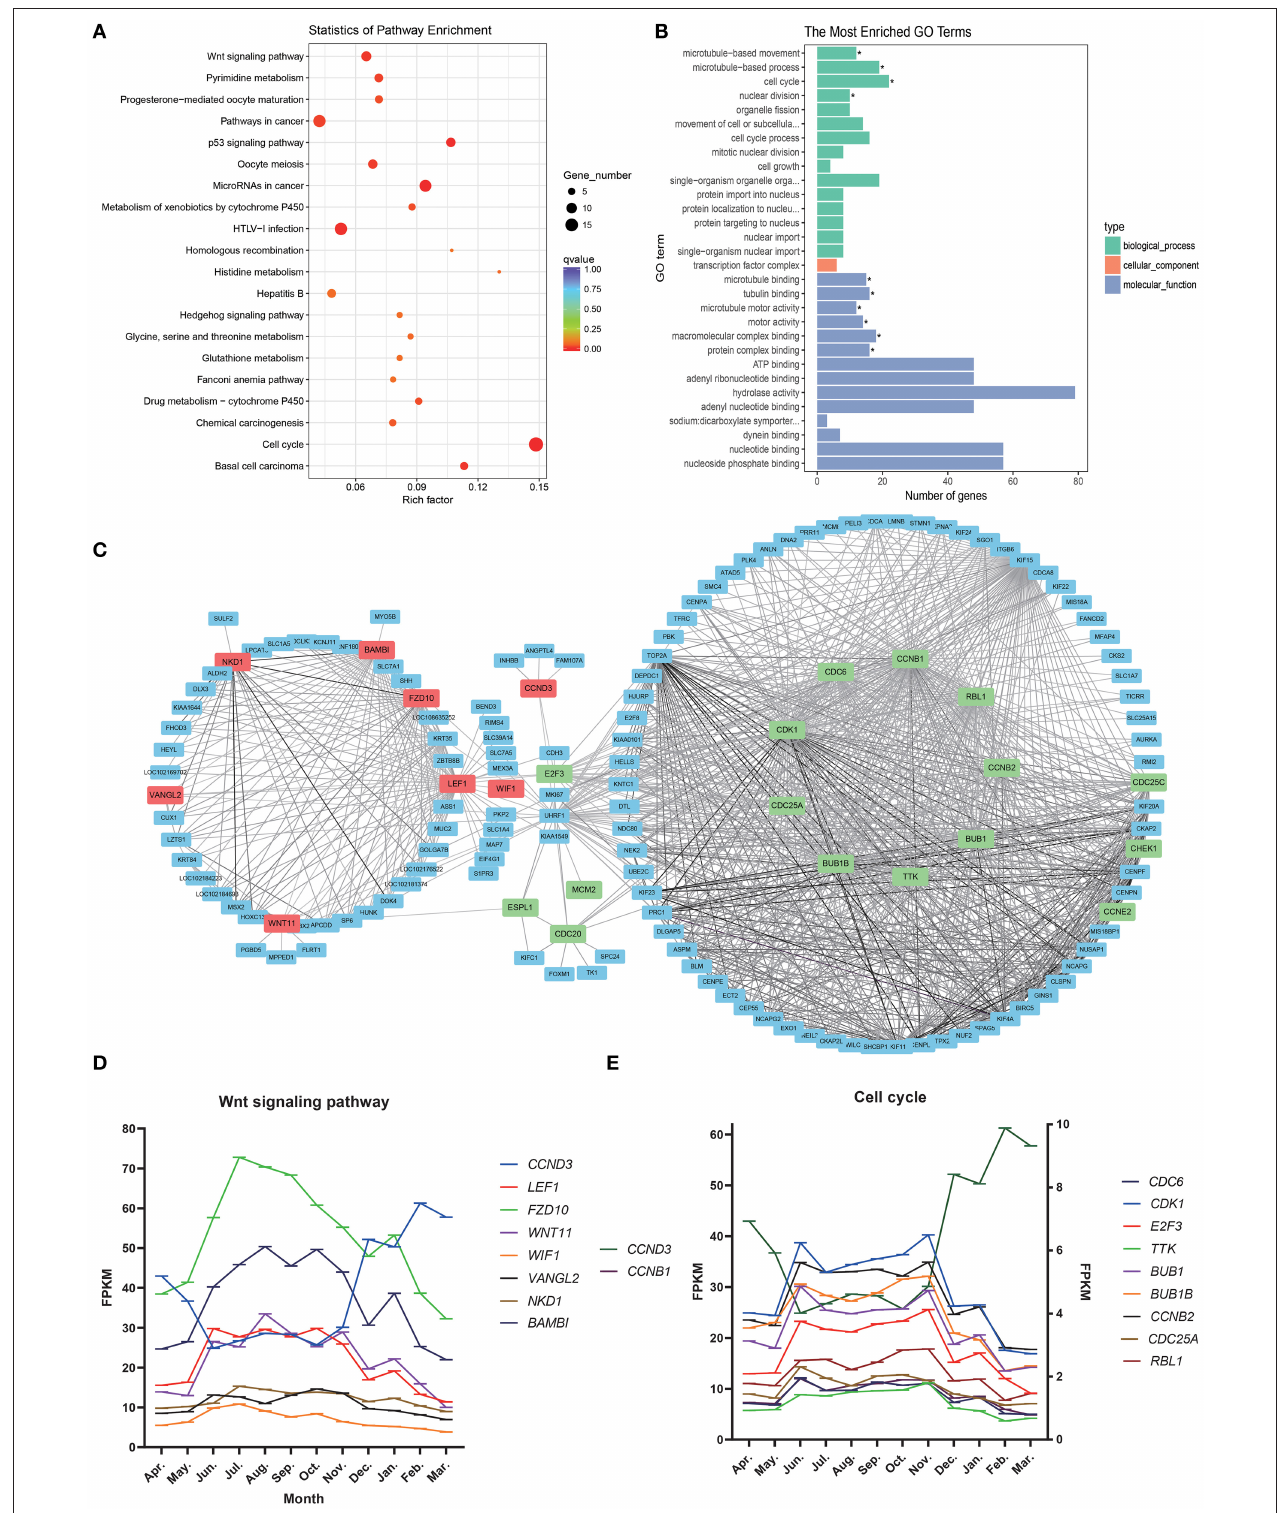
FIGURE 4 | Steelblue module gene analysis map. (A) KEGG enrichment analysis of steelblue module. (B) GO analysis of steelblue module. (C) Gene co-expression network in steelblue modules. (D) Gene expression trend of wnt signaling pathway, Abscissa indicates month, in which the anagen (April–November), catagen (December–January) and telogen (February–March), the ordinate is FPKM. (E) Gene expression trend of cell cycle, CCNB, and CCND3 use the left ordinate axis, other genes use the left coordinate axis.